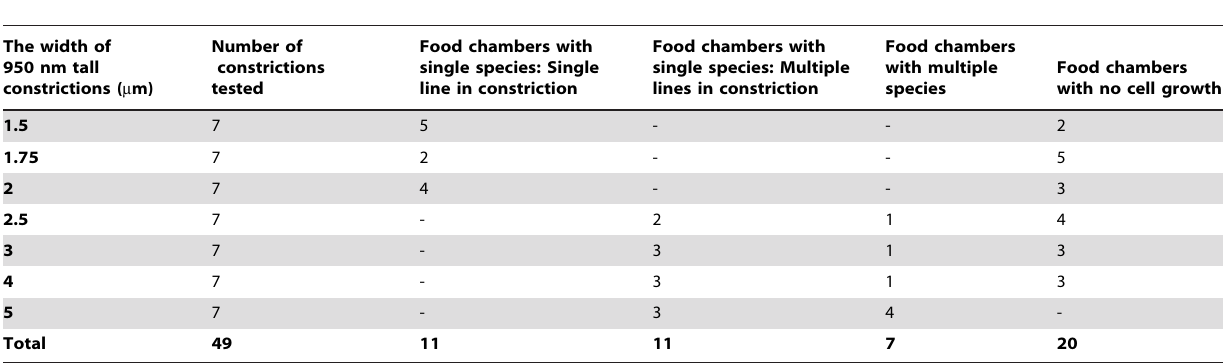
Table 1. Separation efficiency data of devices: 49 constrictions with various widths were used to separate a mixture of CFP P. aeruginosa and m-cherry E. coli .